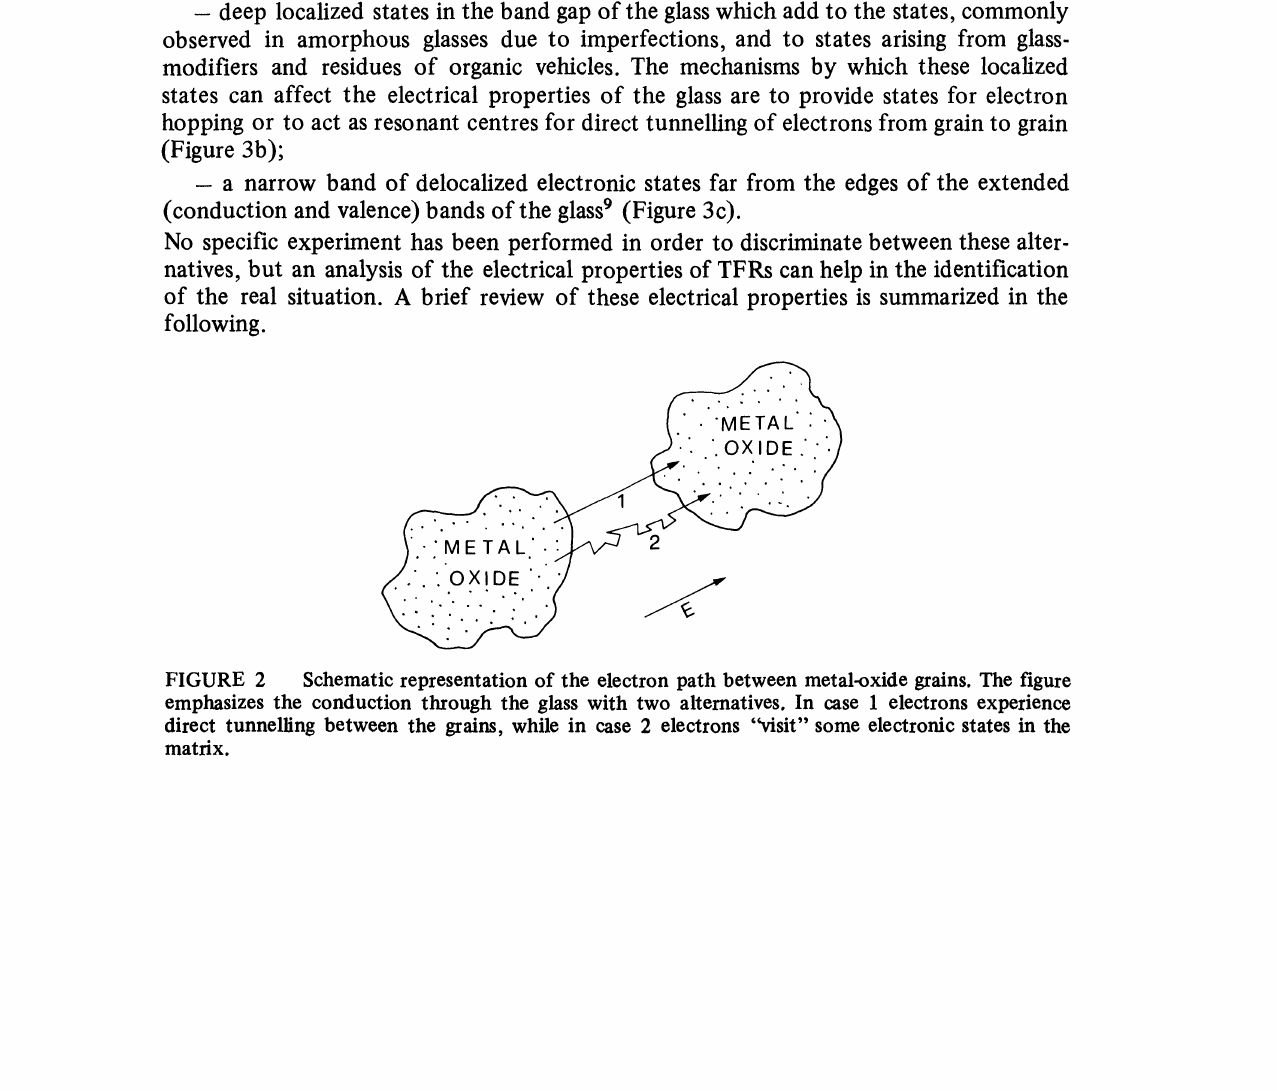
Schematic representation of the electron path between metal-oxide grains. The figure emphasizes the conduction through the glass with two alternatives. In case electrons experience direct tunnelling between the grains, while in case 2 electrons "visit" some electronic states in the